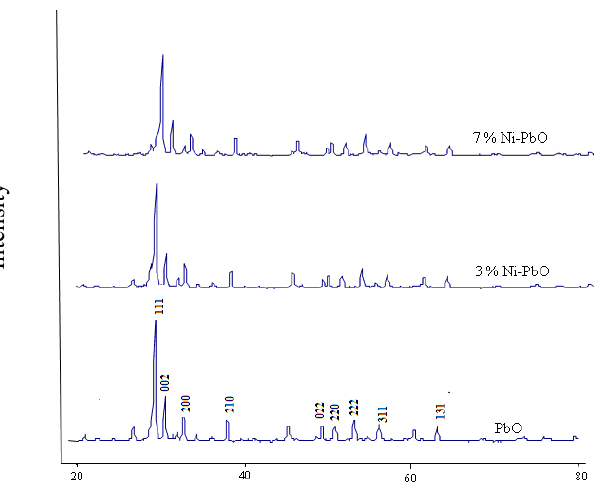
Figure 4 . XRD pattern of PbO, 3% and 7% Ni doped PbO nanoparticles.